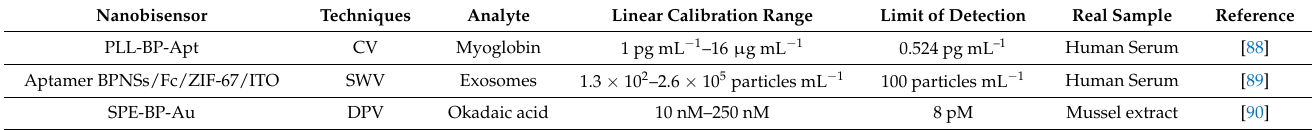
Table 3. Summary of discussed black phosphorous based nanobiosensors with electroanalytical